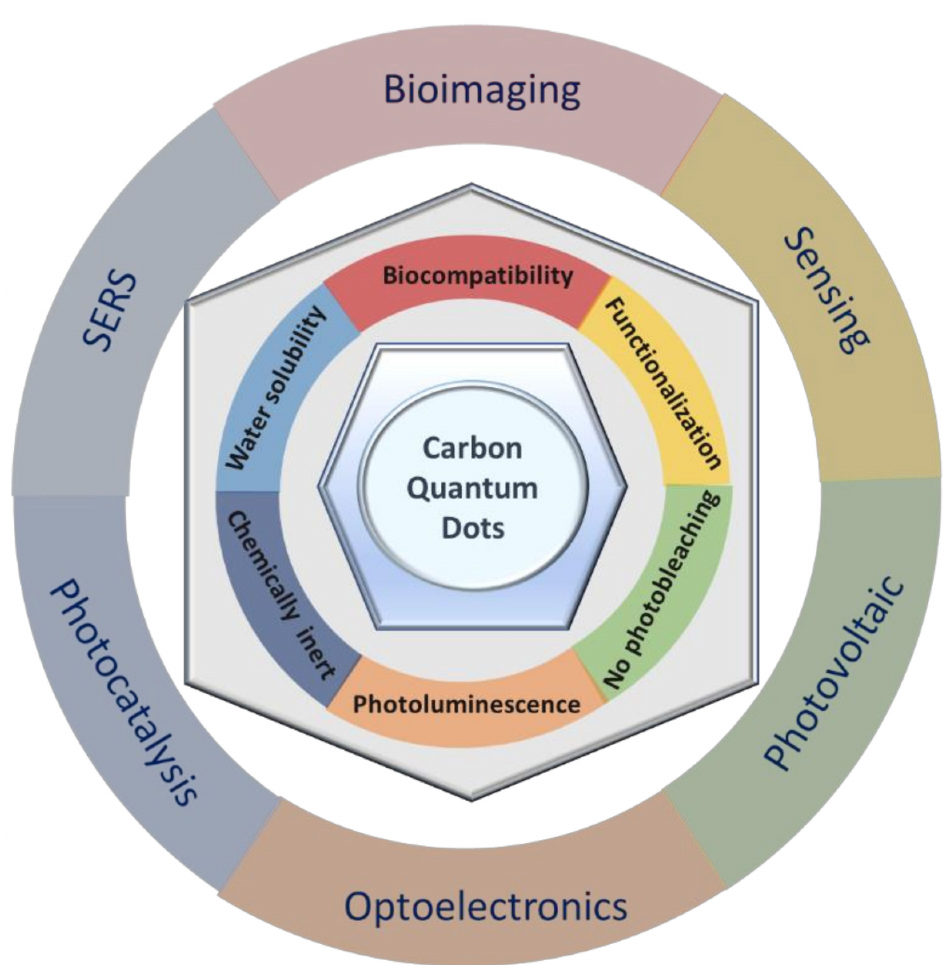
Figure 10. Schematic correlation between CQDs’ physical and chemical properties and possible applications in various